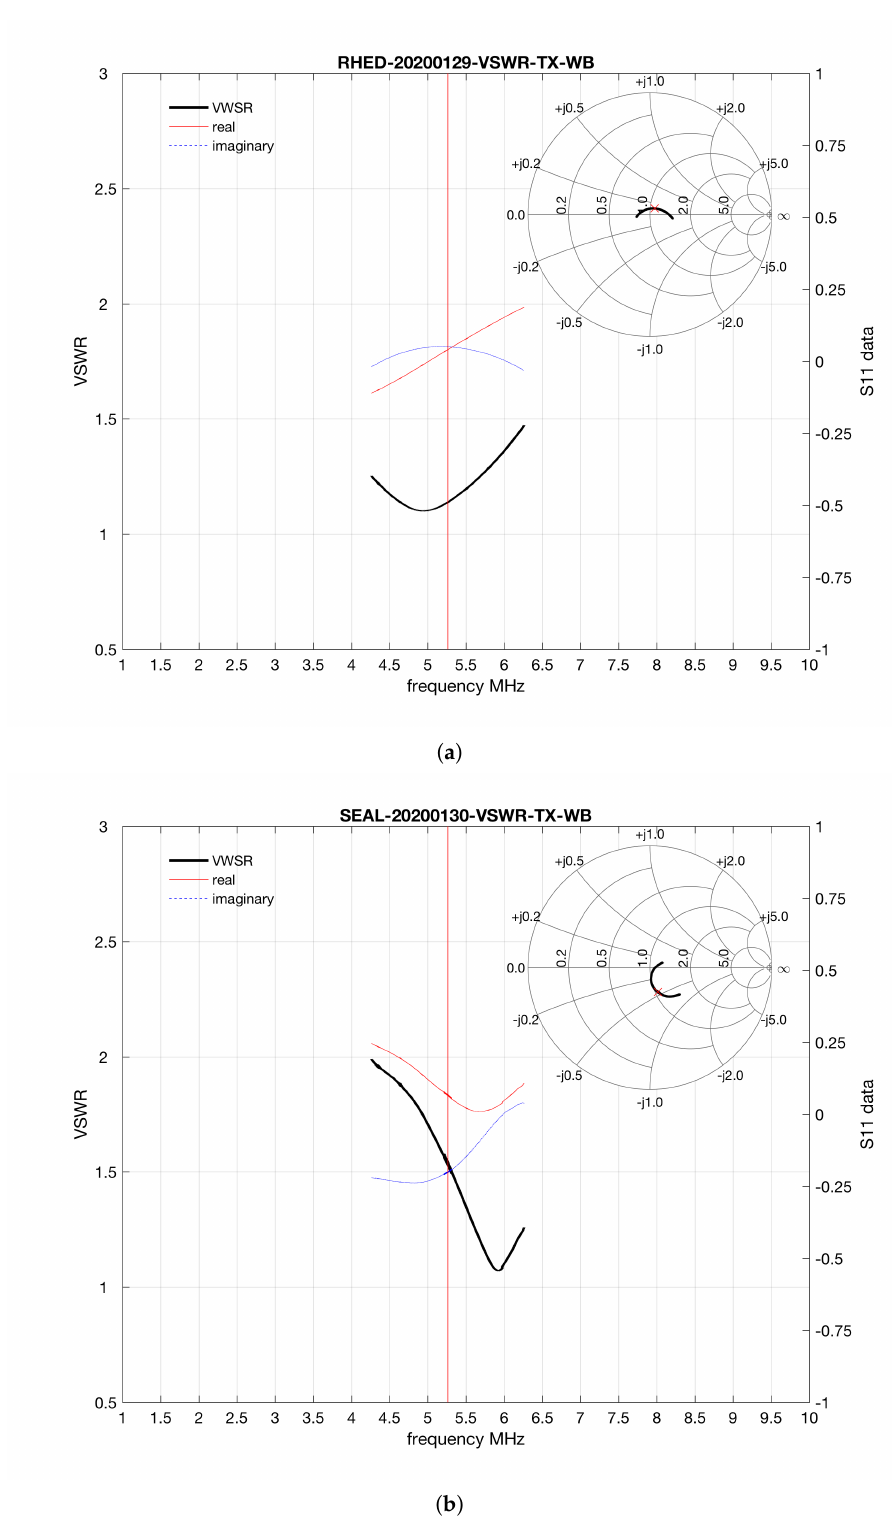
Figure 9. Voltage Standing Wave Ratio (VSWR; black line) and real-imaginary parts of the reflection scattering coefficient ( s 11 ); red and blue line, respectively over frequency for the TWLA deployed at Red Head ( a ) and Seal Rocks ( b ), along with the Smith chart diagram for the same frequency range. The vertical red line corresponds to the 5.2625 MHz frequency of operation of the SeaSonde system. In the Smith chart diagram, it is identified with the red cross